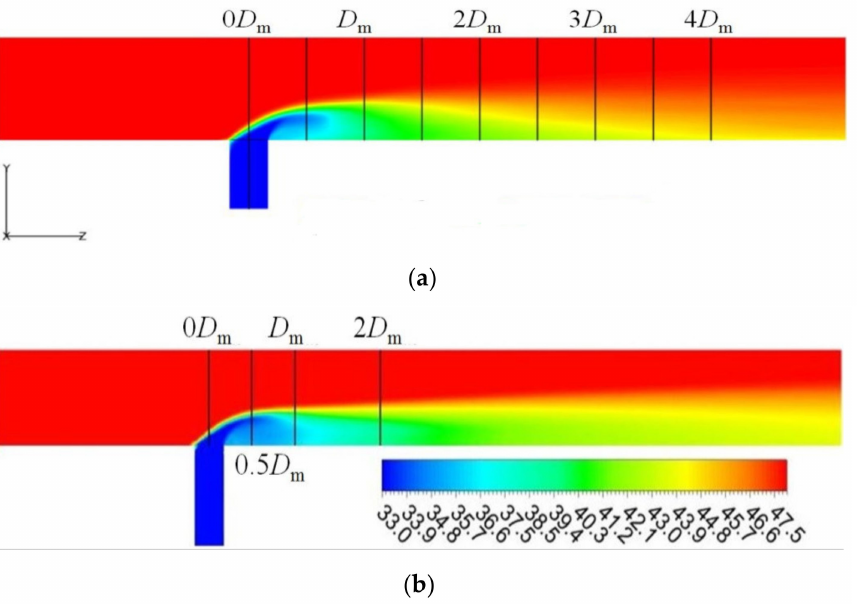
Figure 3. Averaged temperature distribution (in C deg) in the middle section of the T-junction at Re m /Re b = 5.76 obtained by the following approaches: ( a ) LES [11]; ( b )